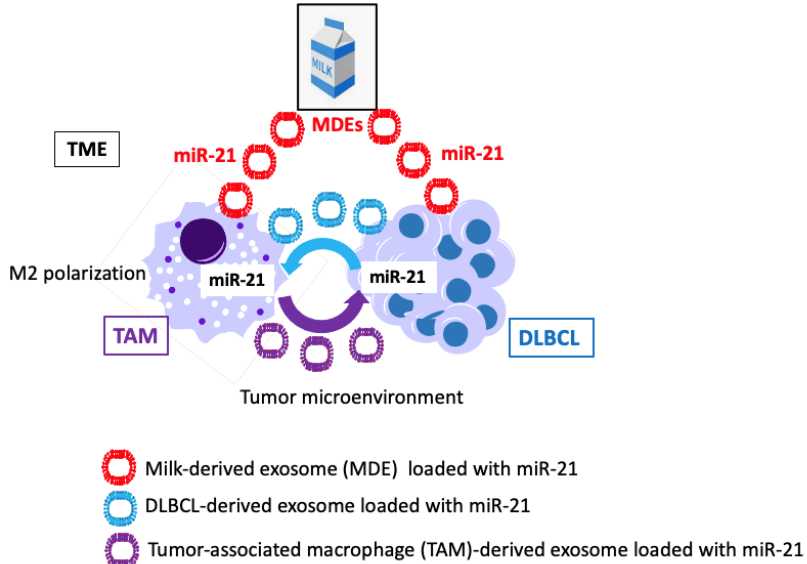
Figure 3. Exosome crosstalk in the tumor microenvironment (TME) of diffuse large B-cell lymphoma (DLBCL). DLBCL cells secrete microRNA-21 (miR-21)-enriched exosomes into the TME to tumor-associated macrophages (TAM), which internalize these tumor-derived exosomes and promote macrophage M2 polarization, favoring tumor growth and progression. TAMs also secrete miR-21-enriched exosomes to DLBCL cells further promoting lymphomagenesis. Bovine milk-derived exosomes (MDEs) also transport miR-21 to recipient cells that may reach TAMs and/or DLBCL cells further augmenting miR-21-mediated oncogenic signaling.